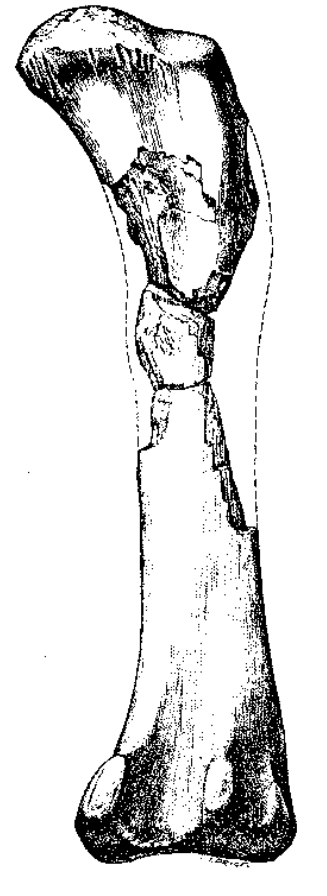
Fig. 3 – One sauropod femur discovered by Llewellyn Ivor Price in Late Cretaceous strata of the locality Mangabeira, Minas Gerais. Unpublished original drawing of